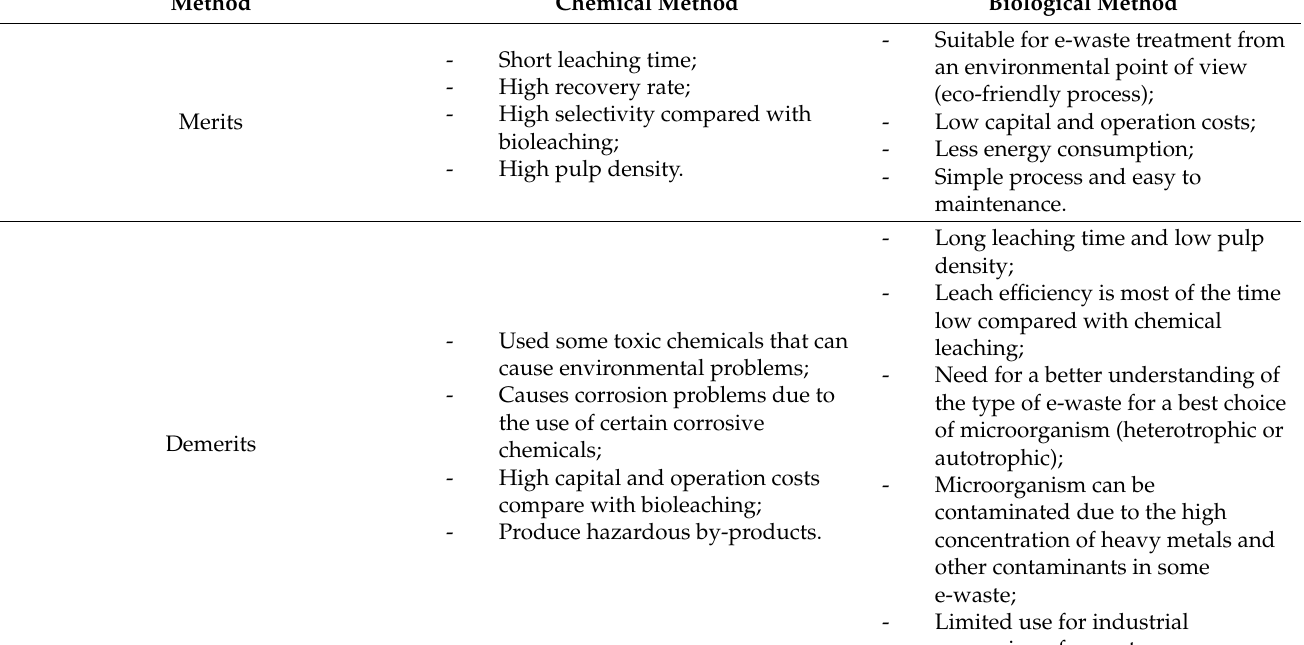
Table 5. The Merits and Demerits of Chemical and biological methods.